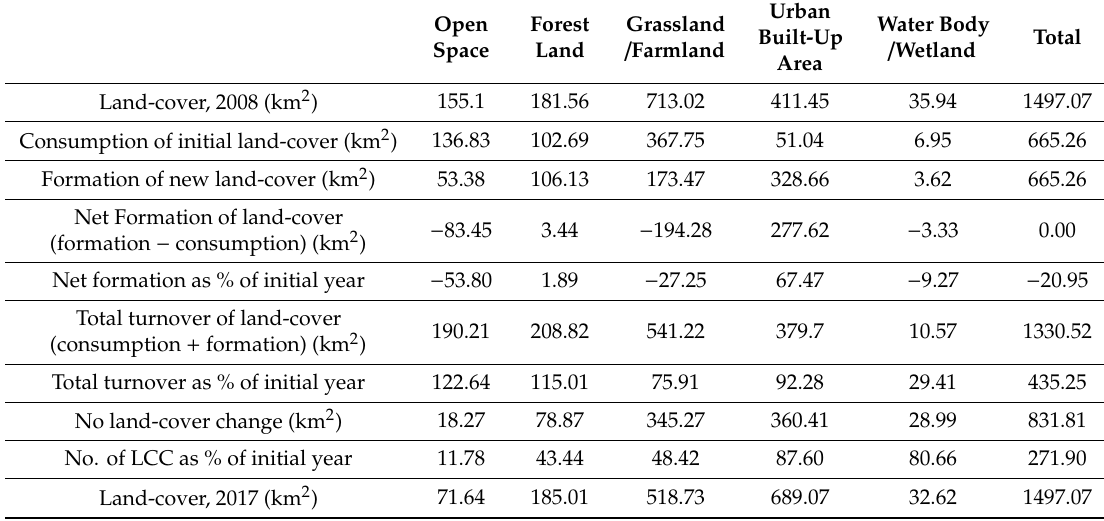
Table 2. Land-cover account for GAMA, 2008–2017.